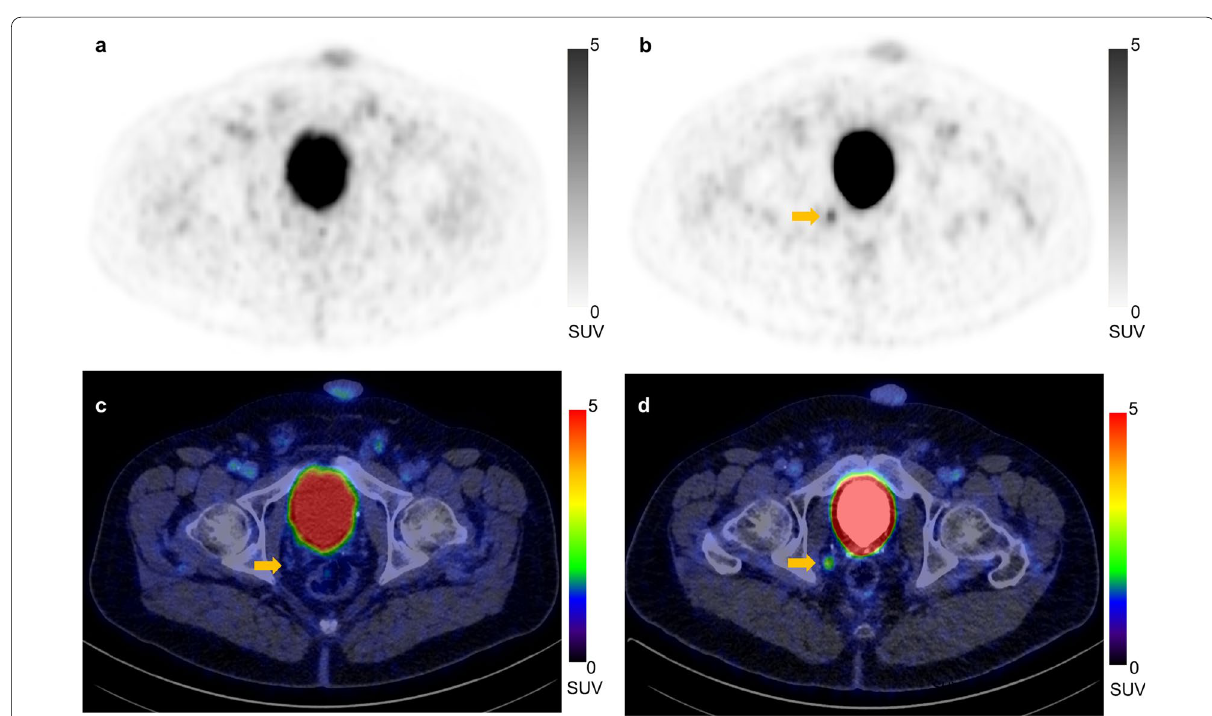
Fig. 2 PET ( a , b ) and PET/CT fusion c , d images of the pelvis with increasing uptake of [. 68 Ga]Ga-PSMA-I&T of a lymph node (arrows) in the deep internal iliac lymph node region on the right side (early scans: a and c; late scans: b and d)